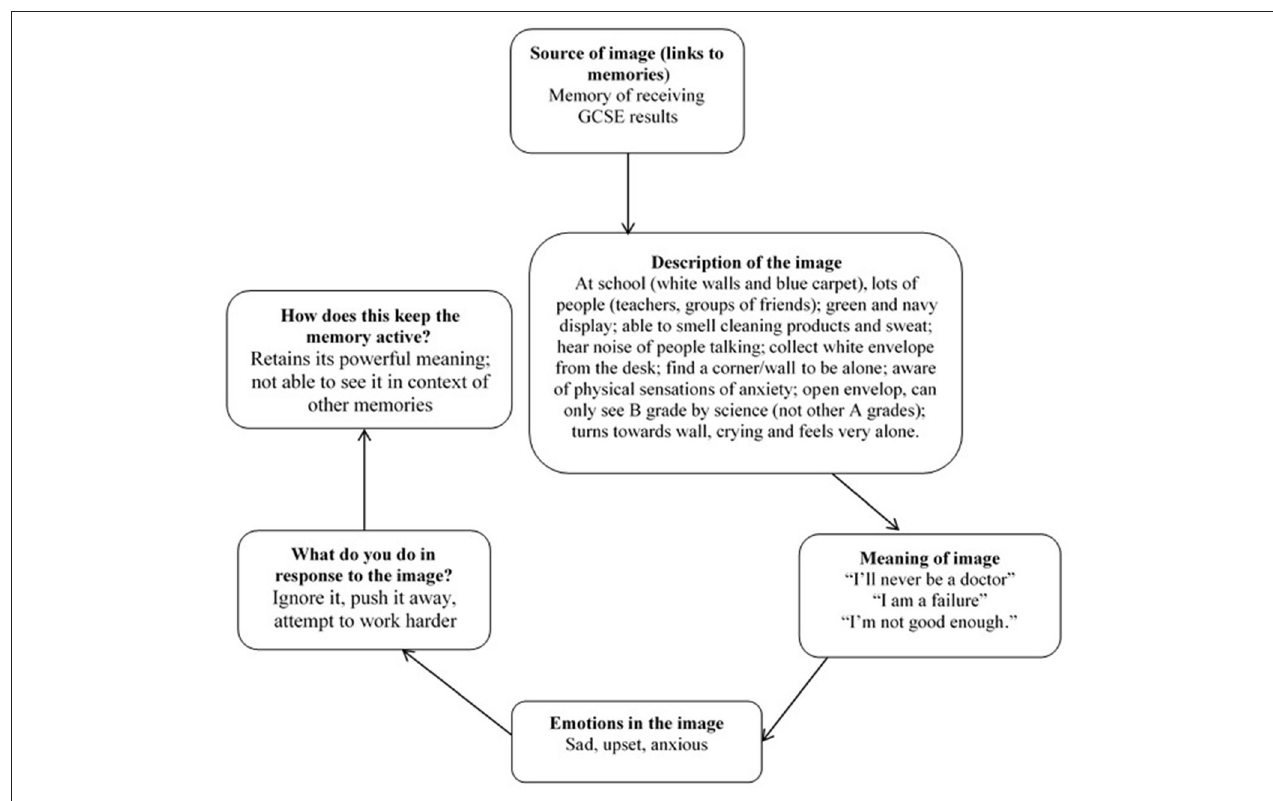
FIGURE 2 | Example formulation of a negative non-traumatic image. The formulation is collaboratively completed in the IR session, during step